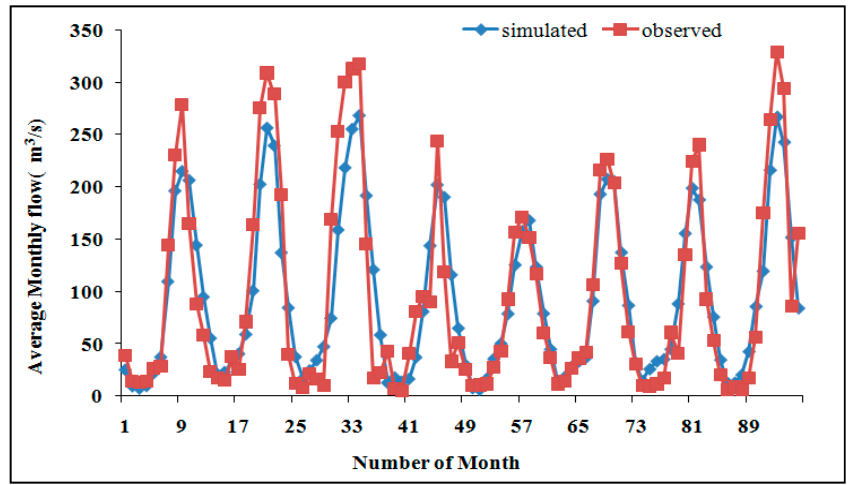
Figure 11. Simulated and observed flow during the calibration period (1997–2004).